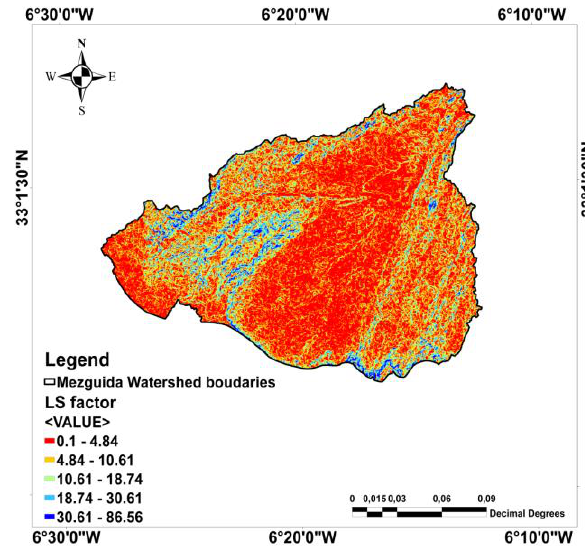
Figure 7. LS factor map